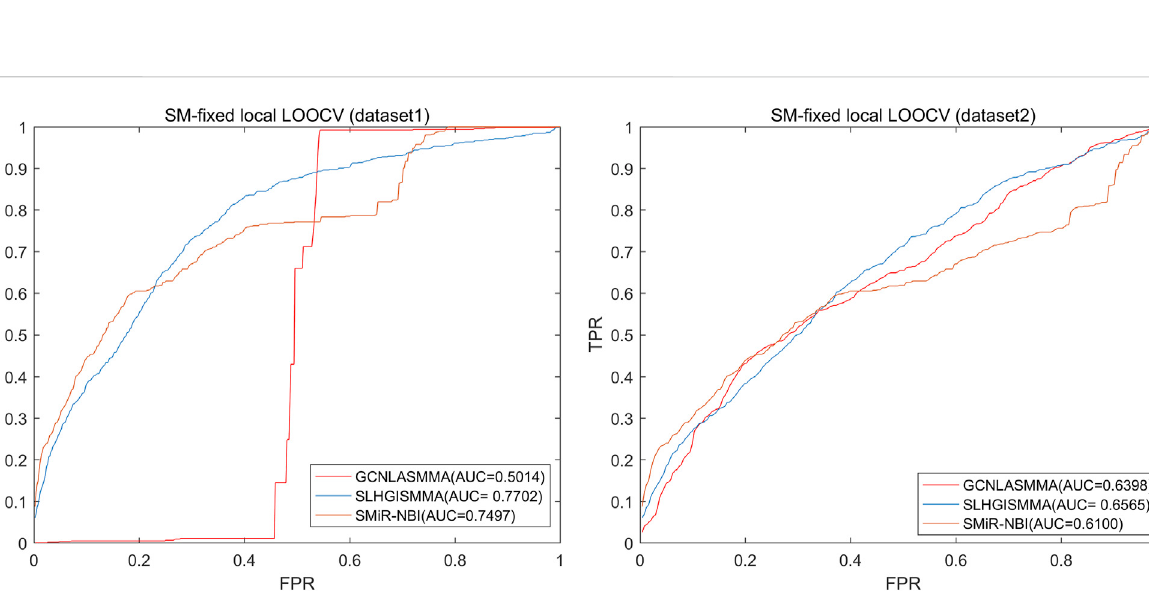
FIGURE 4 The left half of the fi gure shows the comparison of GCNLASMMA with two comparison algorithms under SM- fi xed LOOCV based on dataset1. Asaresult,GCNLASMMA,SLHGISMMAand SMiR-NBIachieveAUCsof0.5014,0.7702and0.7497,respectively. Therighthalfofthe fi gure showsthe comparison of GCNLASMMA with two comparison algorithms under SM- fi xed LOOCV based on dataset2. As a result, GCNLASMMA, SLHGISMMA and SMiR-NBI achieve AUCs of 0.6398, 0.6565 and 0.6100,